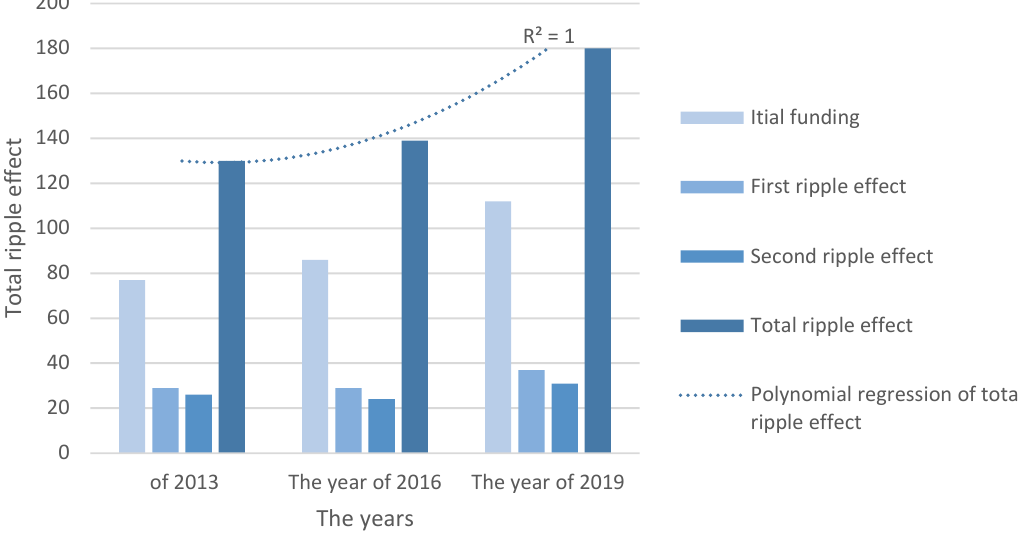
Figure 5. The economic ripple effect of ST in Kagawa. Note: The ripple effect (based on related calculation table in Kagawa) is often used colloquially to mean a multiplier in